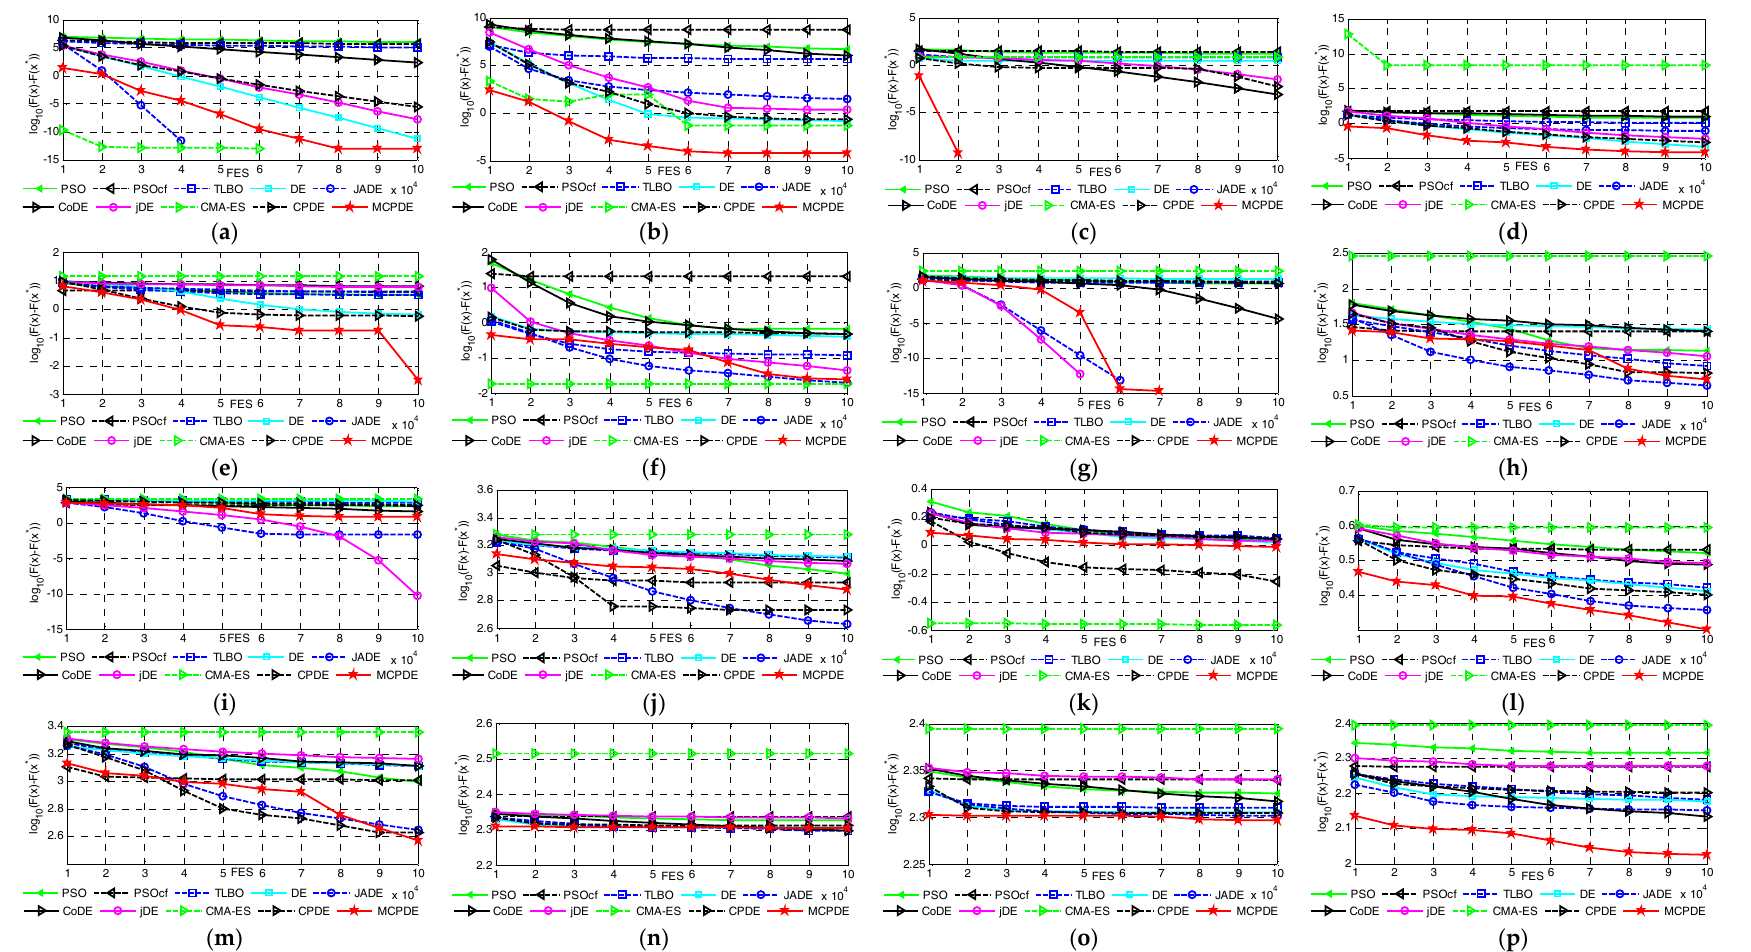
Figure 2. Evolution of the mean function error values derived from PSO, PSOcf, TLBO, DE, JADE, CoDE, jDE, CMA-ES, CPDE and MCPDE versus the number of FES on sixteen test problems with D = 10. ( a ) f 2 ; ( b ) f 3 ; ( c ) f 6 ; ( d ) f 7 ; ( e ) f 9 ; ( f ) f 10 ; ( g ) f 11 ; ( h ) f 12 ; ( i ) f 14 ; ( j ) f 15 ; ( k ) f 16 ; ( l ) f 20 ; ( m ) f 23 ; ( n ) f 24 ; ( o ) f 25 ; ( p ) f 26 .